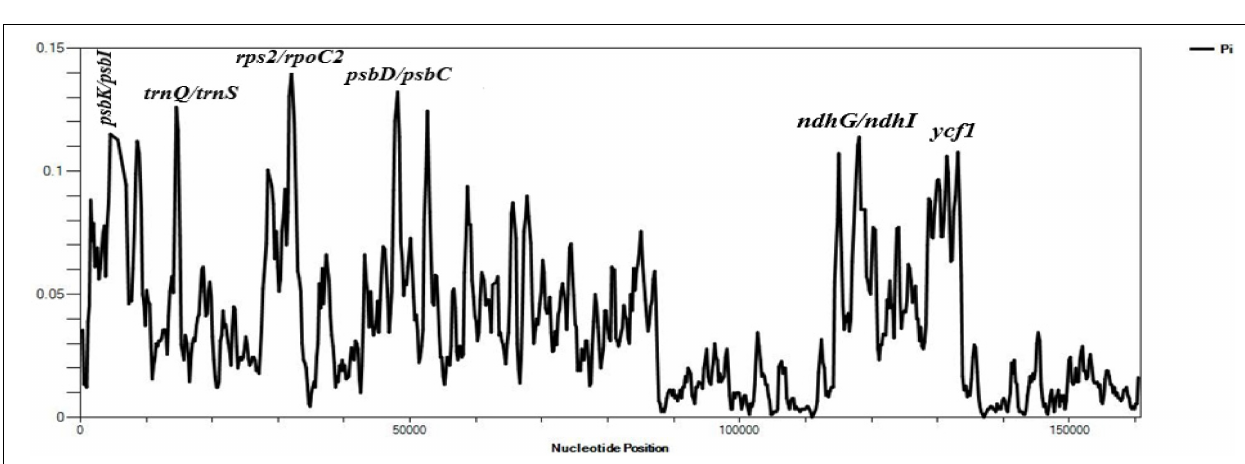
FIGURE 5 | Sliding window analyses of the three whole cp genome sequences using a window length of 600 bp and step size of 200 bp. The nucleotide diversity ( Pi ) value of each window is shown on the Y-axis, and their positions showed on the X-axis.